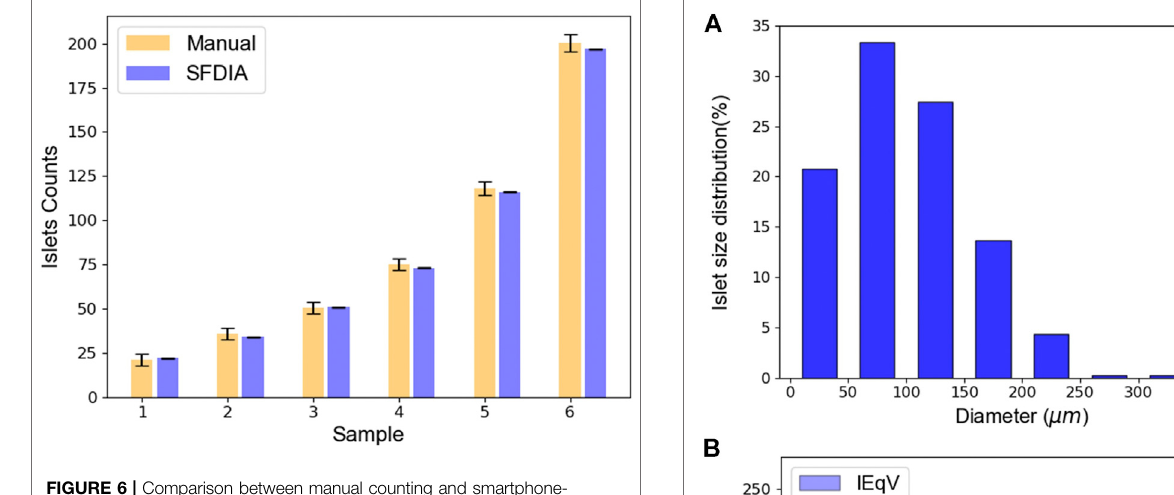
FIGURE 6 | Comparison between manual counting and smartphone- based counting. Six human islet samples of varied sample sizes were assessed by both manual counting and the SFDIA system. Results were plotted and expressed in mean +/ − SD. NS: Not Signi fi cant ( p -value > 0.05), N (cid:1) 5.